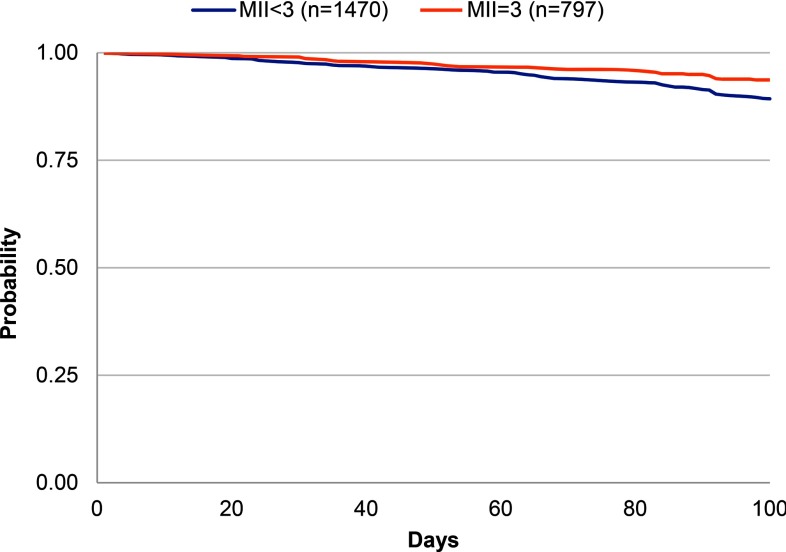
Kaplan-Meier Survival Curves of Contraceptive Continuation by MIIAbbreviation: MII, Method Information Index.